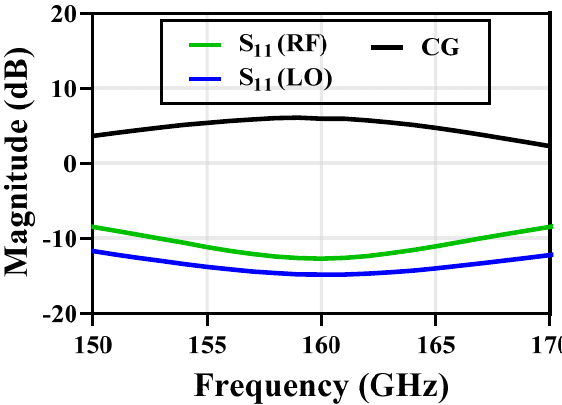
Figure 5. Simulation results of quadrature mixer.